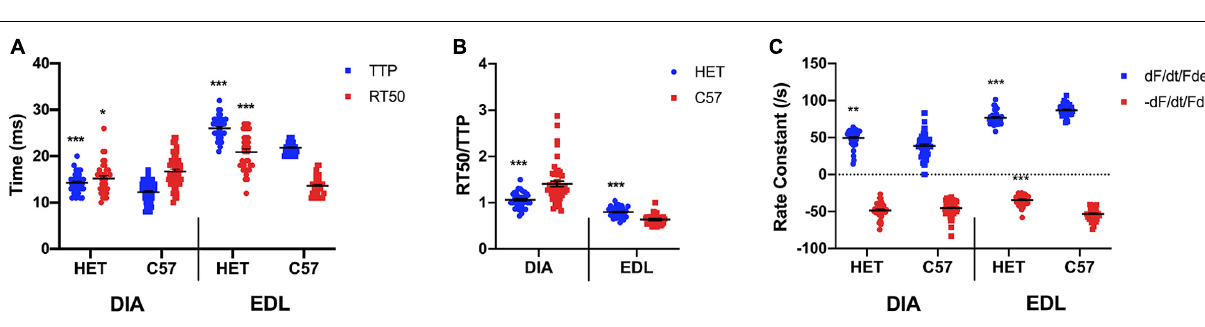
FIGURE 2 | (A) Time to peak and 50% relaxation of 20 week old dystrophic and wildtype muscle types. Kinetic analysis was conducted in diaphragm and EDL muscles from the same mice. Mouse models include dystrophic HET and wildtype C57BL/10. Statistical analysis was conducted using a two-sided t -test. * indicates P < 0.05, ** indicates P < 0.01, and *** indicates P < 0.001 compared to C57BL/10 mice. The line represents the group mean; error bars are standard error of mean. (B) Ratio of time to 50% relaxation and time to peak (RT50/TTP). Mouse models include dystrophic HET and wildtype C57BL/10. Statistical analysis was conducted using a two-sided t -test. *** indicates P < 0.001 compared to C57BL/10 mice. The line represents the group mean; error bars are standard error of mean. (C) Rate constants of individual diaphragm and EDL twitches. Mouse models include dystrophic HET and wildtype C57BL/10. Statistical analysis was conducted using a two-sided t -test. ** indicates P < 0.01, *** indicates P < 0.001 compared to C57BL/10 mice. The line represents the group mean; error bars are standard error of